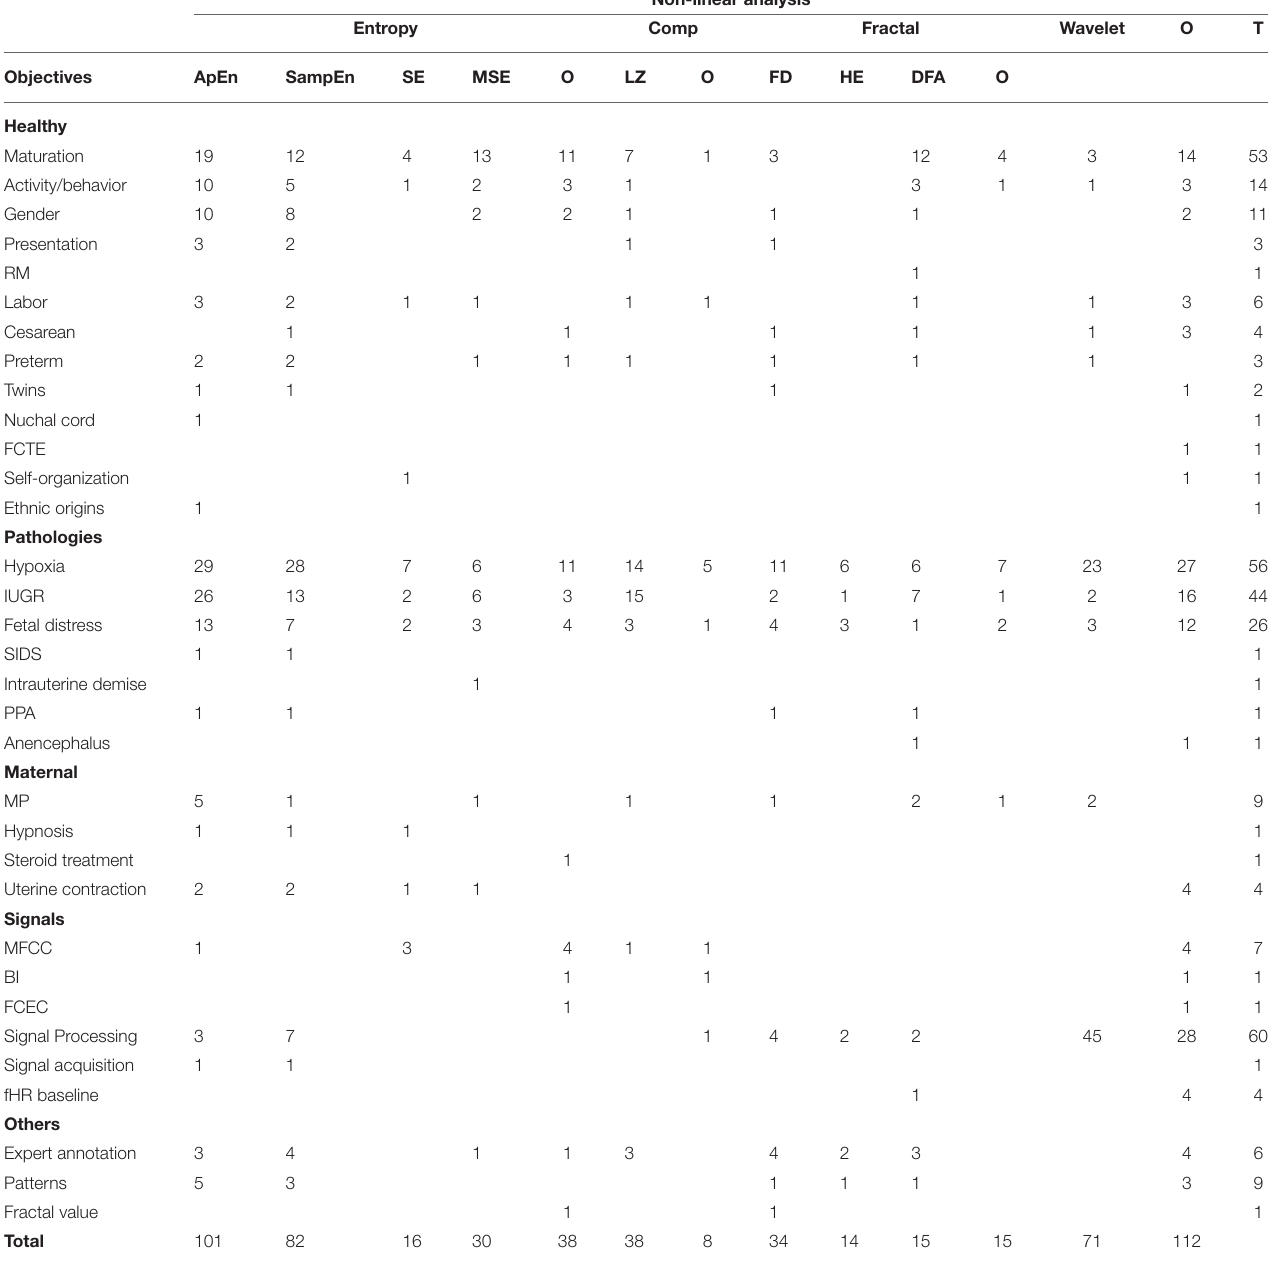
TABLE 2 | Research objectives and non-linear methods of the papers selected. Non-linear analysis Entropy Comp Fractal